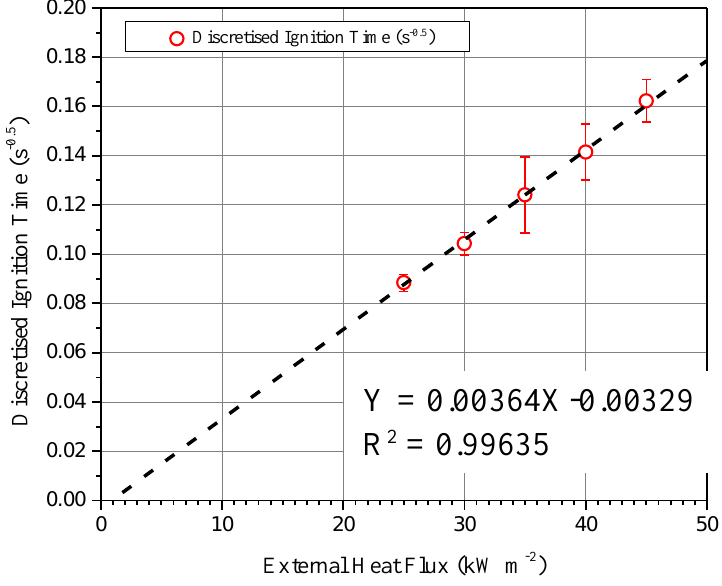
Figure 7. Square root of the inverse of ignition time (s − 0.5 ) as a function of radiant heat flux (kW m − 2